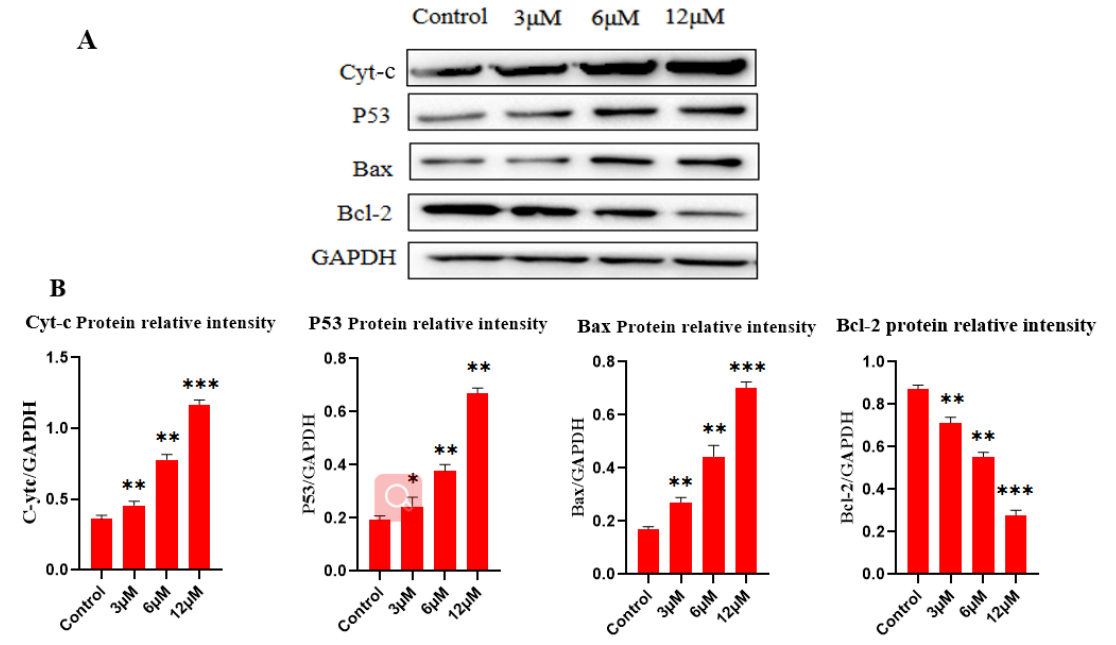
Figure 8. Effects of compound 8f on the expression of Bax, Bcl-2, Cyt-c and P53 in MCF-7 cells. ( A ) Western blot analysis showing Bax, Bcl-2, Cyt-c and P53 protein expression level. ( B ) Data were revealed as the means ± SD for independent tests in triplicate. * p < 0.05, ** p < 0.01, *** p < 0.001 vs. control ( 8f 0 μ M) group.